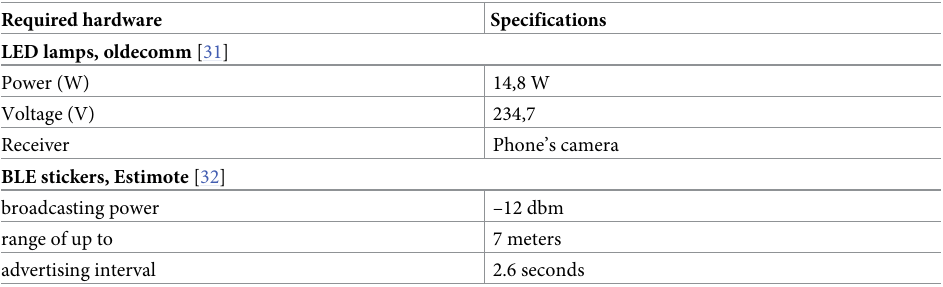
Table 2. Experiment